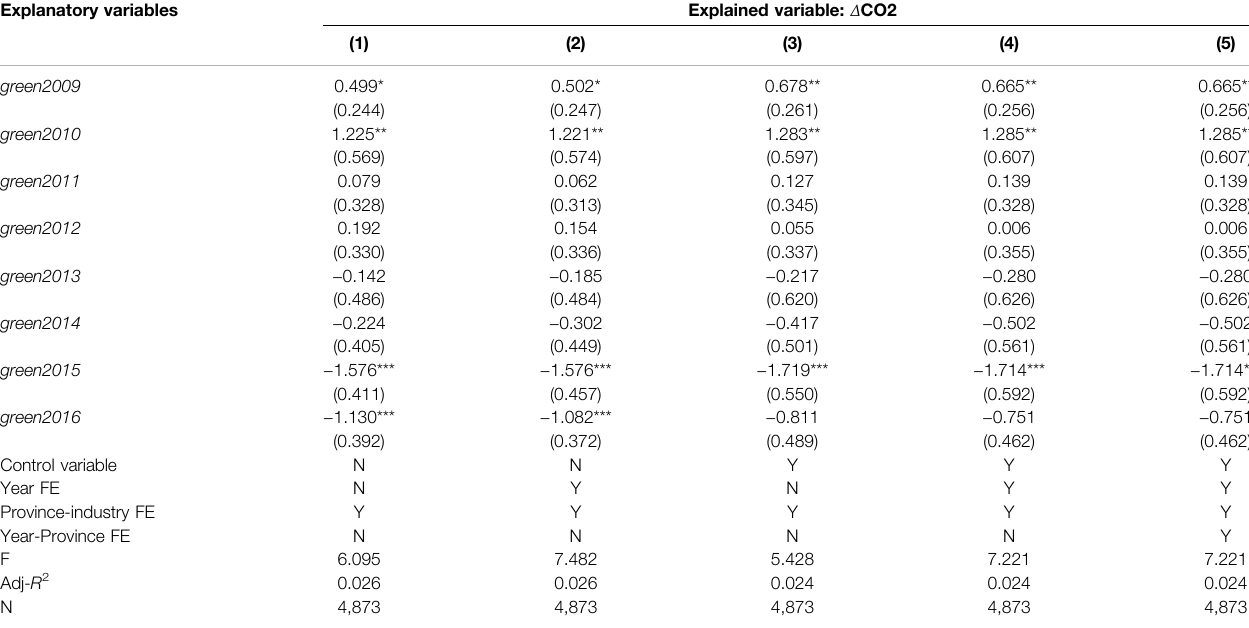
TABLE 5 | Dynamic effect analysis.